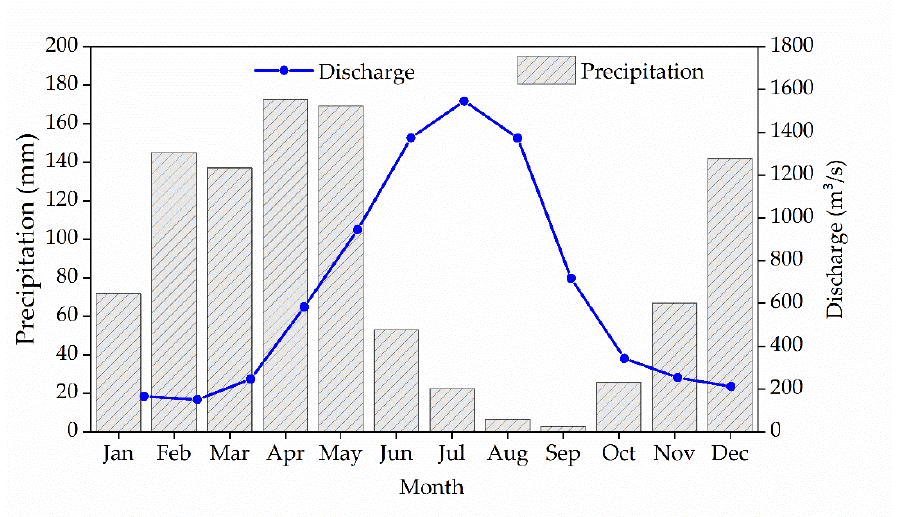
Figure 2. The monthly dynamics of the streamflow and precipitation in the Upper Vakhsh River Basin in Central Asia (Darband station).